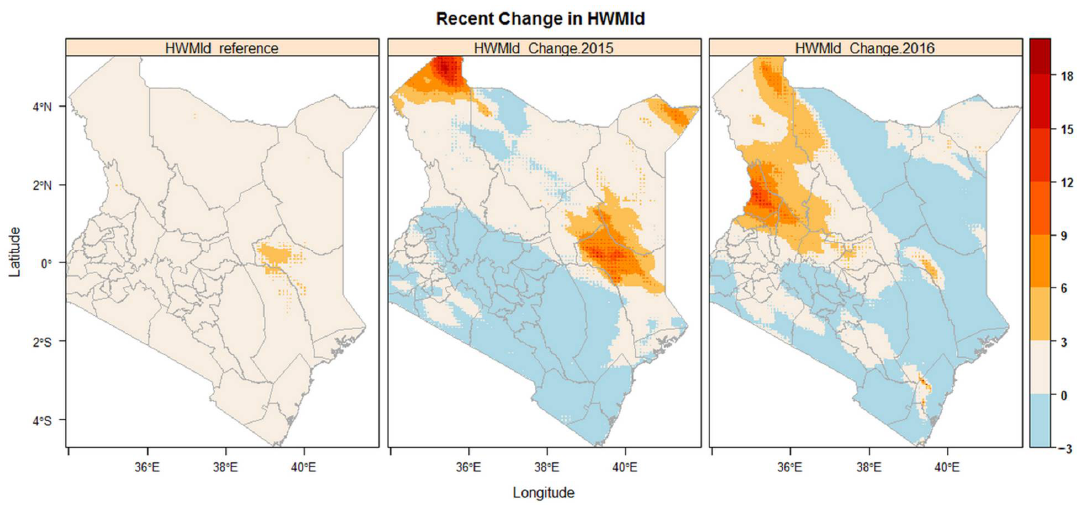
Figure 6. Recent changes in HWMId 2015 ( middle ) and 2016 ( right ) relative to the reference period ( left ).